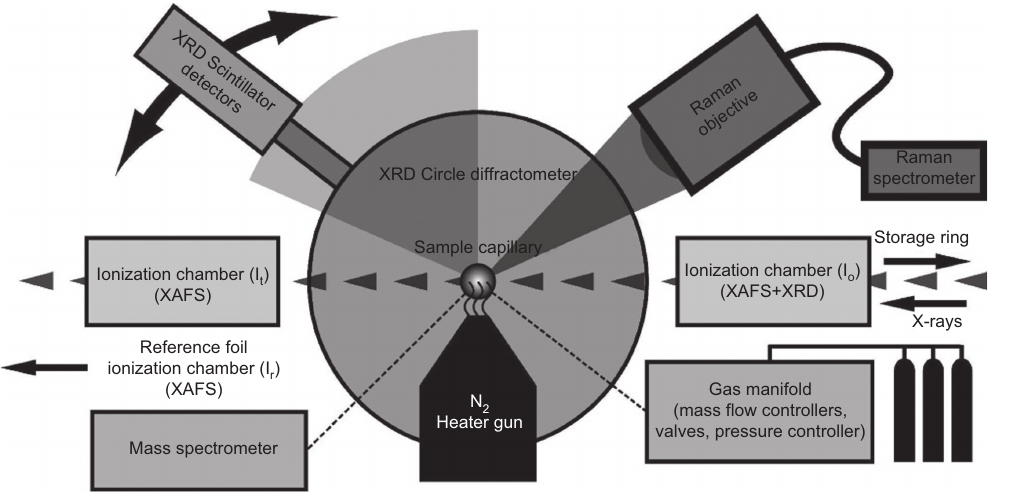
Figure 9 Schematic representation of the combined XAFS/XRD/Raman experimental setup (Reprinted with permission from ref [157]. Copy- right (2010) American Chemical